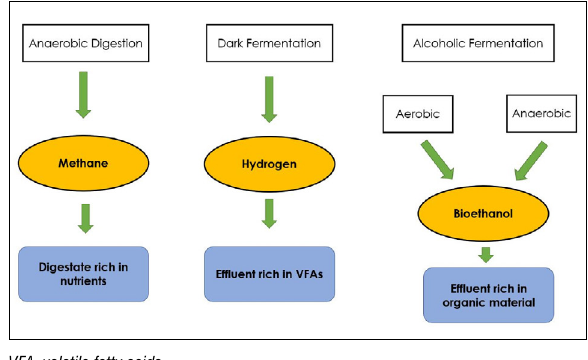
Schematic of potential biorefinery technologies that are capable of being coupled with bioplastic production.